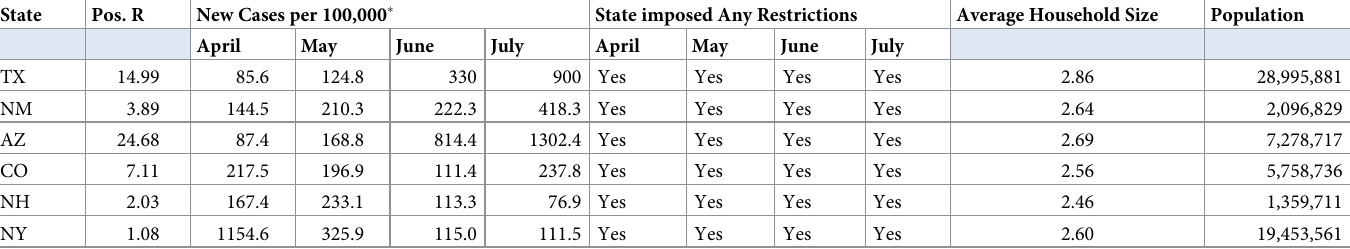
Table 1. Overview of